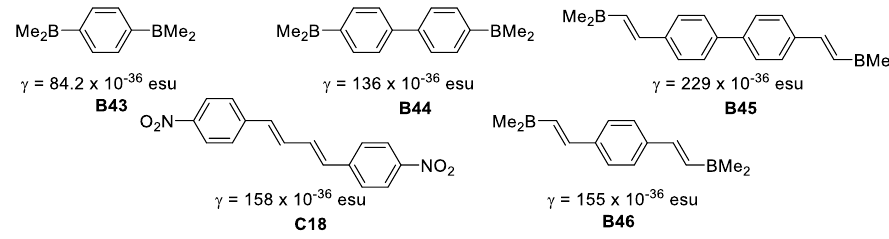
Figure 23. Second order hyperpolarizabilities for symmetric dimesitylboranes.